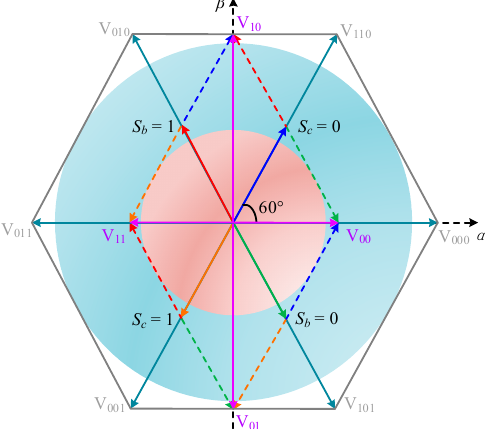
Figure 5. Space vector allocations for the SSTP and FSTP converters.